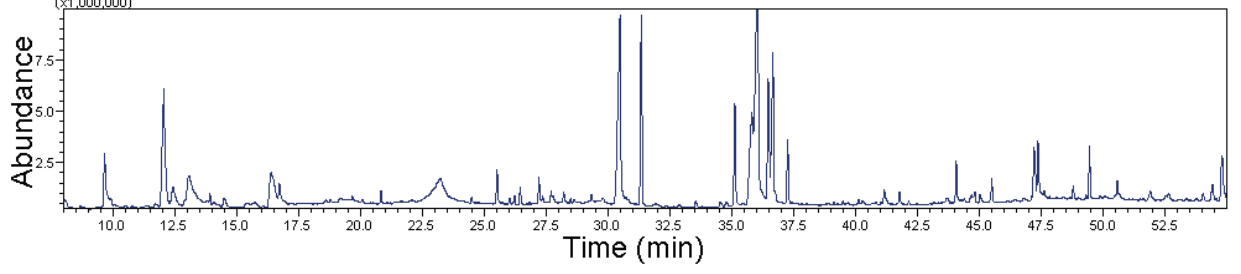
Figure 1. GC-MS chromatogram of ethanol extract of whole plant of E. hirta showing the different peaks of compounds present in the extract.